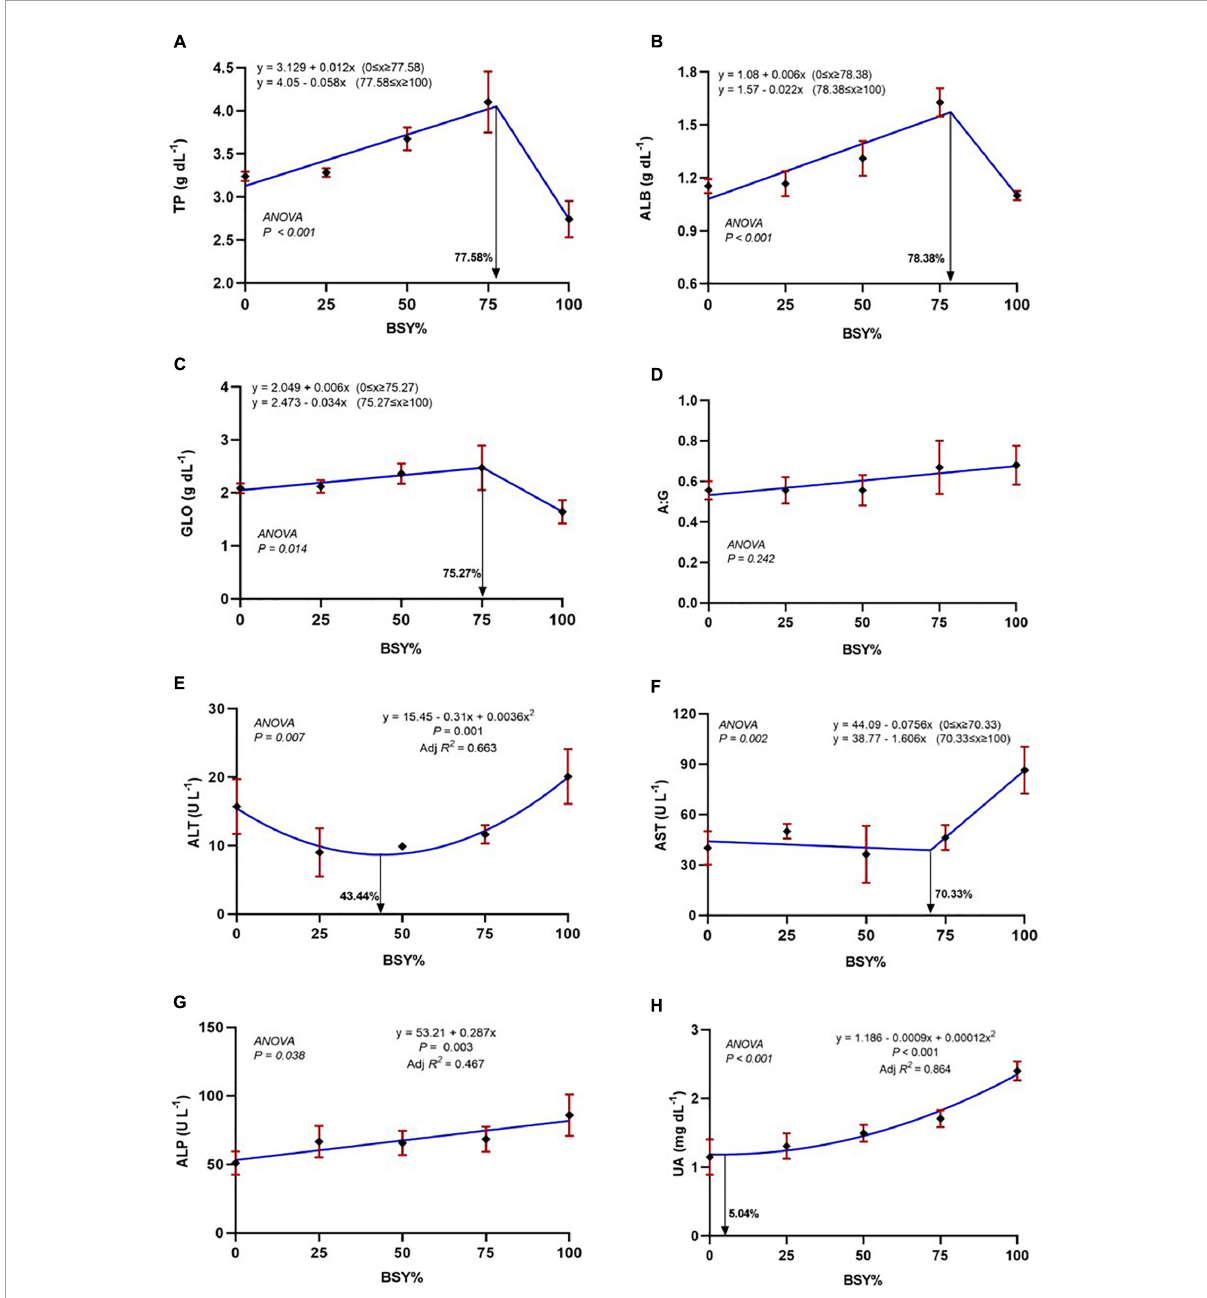
FIGURE4 The responses of serum biochemical parameters of climbing perch fingerlings fed with BSY incorporated diet for 60 days. The X-axis represents the gradient inclusion levels of BSY in the place of fishmeal. (A) TP, Total protein (g dL − 1 ); (B) ALB, Albumin (g dL − 1 ); (C) GLO, Globulin (g dL − 1 ); (D) A:G ratio (E) ALT, Alanine aminotransferase (U L − 1 ); (F) AST, Aspartate aminotransferase (U L − 1 ); (G) ALP, Alkaline phosphatase (U L − 1 ) and (H) UA, Uric acid (mg dL − 1 ). The values are expressed as Mean ± SD, n = 3.